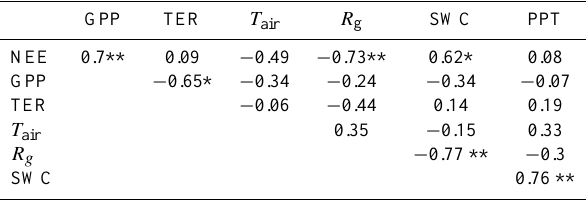
Table 2. Bivariate correlation coefficients between annual anoma- lies in NEE, GPP and TER and mean annual climate variables in- cluding air temperature ( T air ), global radiation ( R g ), soil water con- tent (SWC) and precipitation (PPT). Statistically significant corre- lations are marked with **( p < 0 . 01) and *( p < 0 .